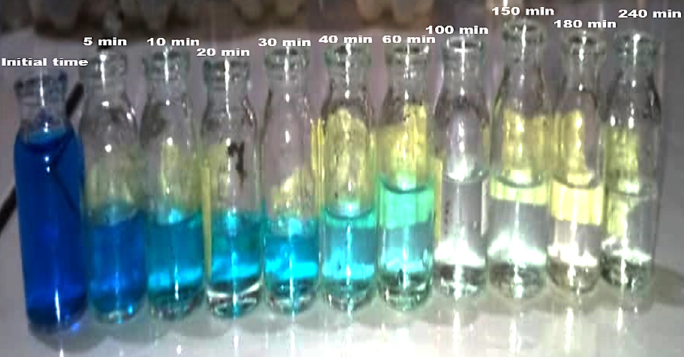
Figure 1. Images showing discoloration of indigo carmine solution over time after treatment.